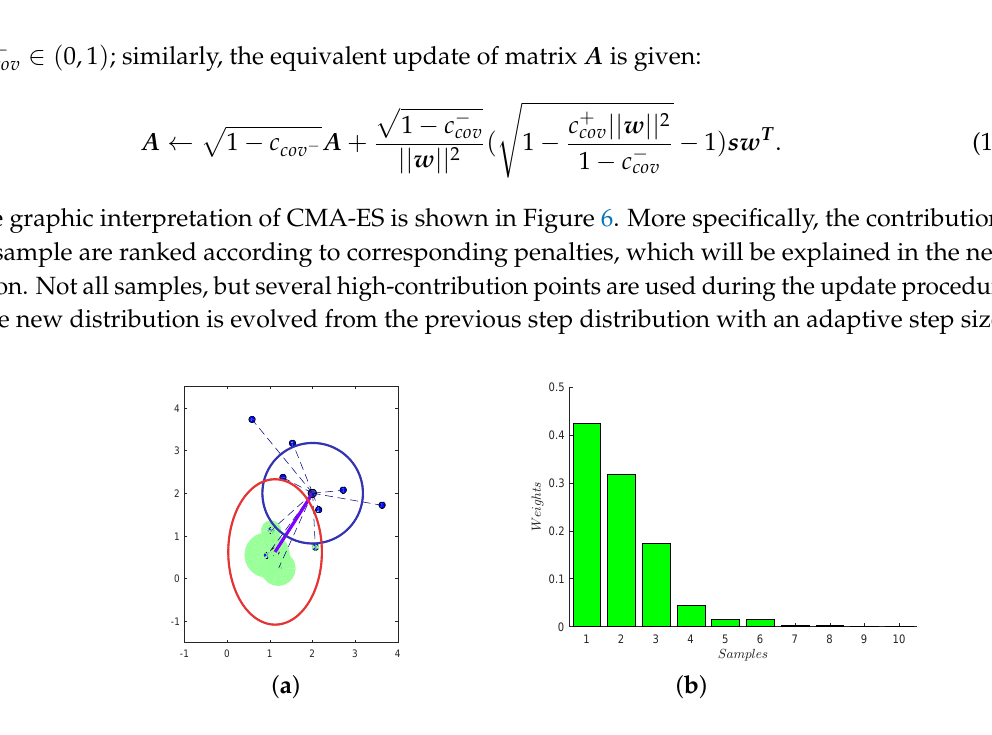
Figure 6. Visualization of CMA-ES exploration and updating rules. In ( a ), the new distribution is shown in the red ellipse, while the last-step distribution is in blue. The quantity of the contributions of each sample is defined with the area of the green circles. Consequently, these contributions are also ranked in ( b ). ( a ) Sampling, estimation and new distribution; ( b ) contributions of the